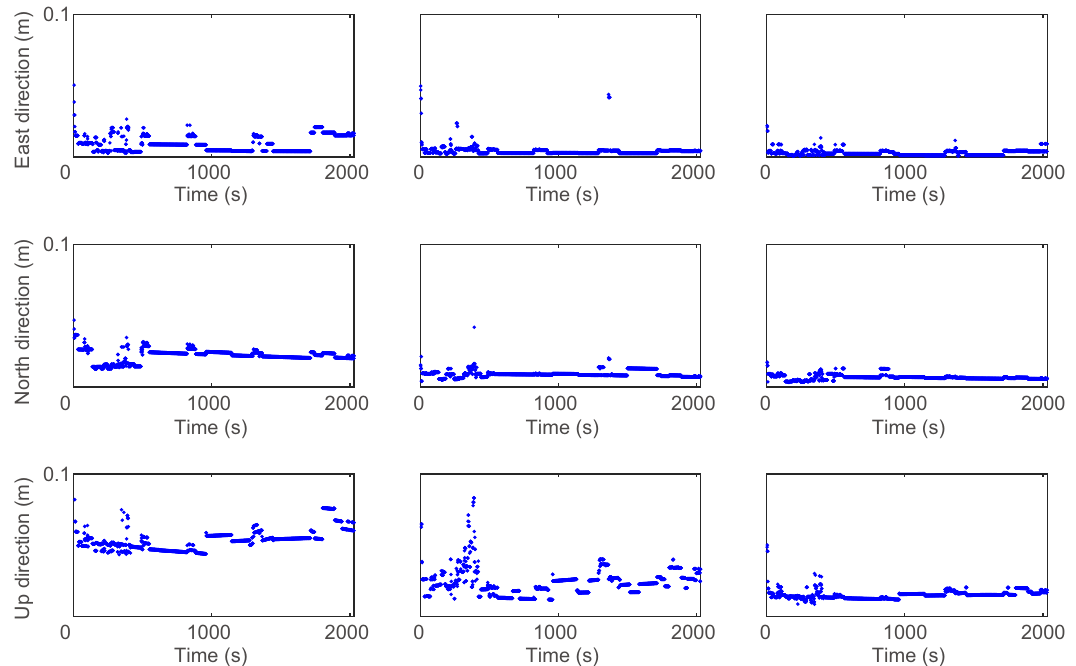
Fig. 11 Variations in the protection levels of the second kinematic dataset for PPP-WAR model with regional atmospheric corrections (left), PPP-AR model (middle), and PPP-RTK model (right) after considering the small probability of incorrect ambiguity fixing (with 10 − 8